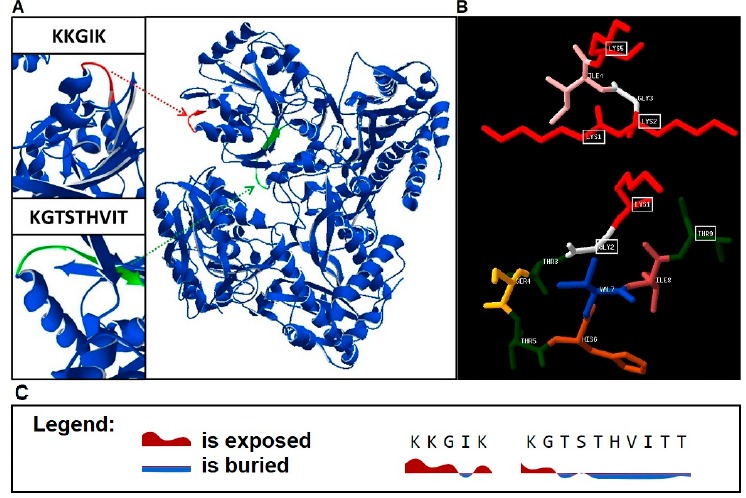
Figure 6. Localization of epitopes of M24 protein. ( A ) Localization of epitopes E4 ( 131 KKGIK 135 ) and E8 ( 184 KGTSTHVIT 192 ). ( B ) The structures of E4 (above) and E8 (below) epitopes obtained by the PEP-FOLD3 and visualized by PDB viewer. ( C ) Results for solvent accessibility analysis of E4 and E8 minimal epitopes obtained by NetSurfP-2.0 with a 25% threshold.